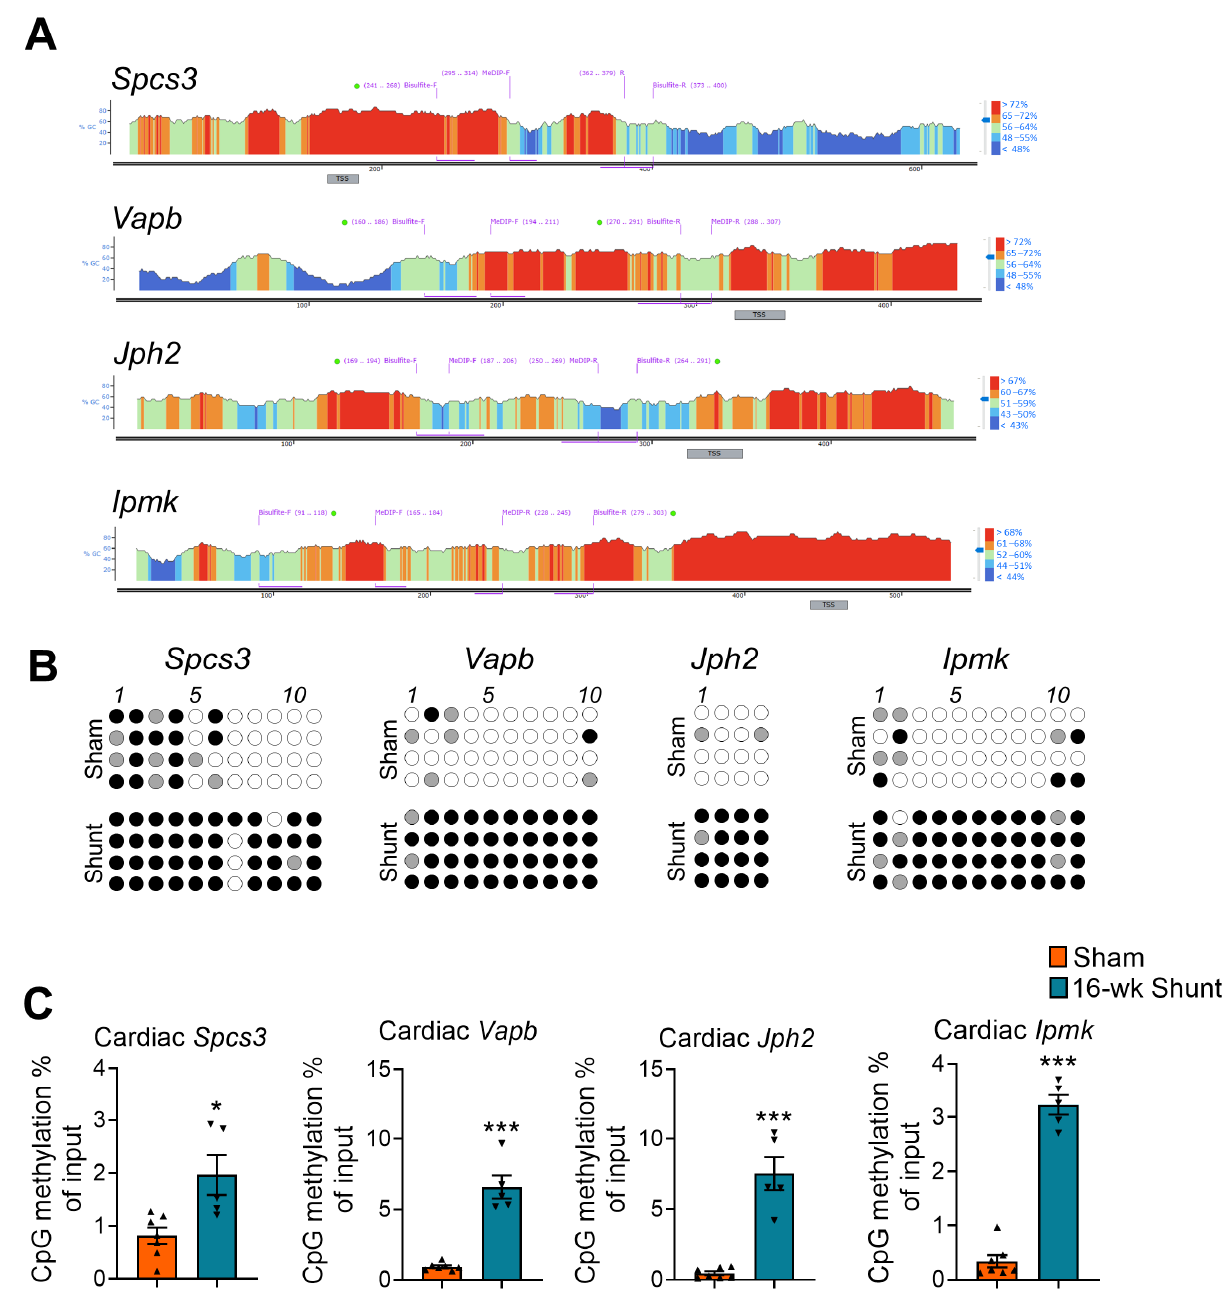
Figure 3. Gene-specific promoter DNA methylation assessment with bisulfite sequencing and MeDIP-qPCR. ( A ) Histogram showing the CpGs content at the gene promoter region. The locations for bisulfite sequencing and MeDIP-qPCR primers are indicated on top of the histogram. ( B ) Bisulfite sequencing analysis showing the methylation status of CpGs at the selected candidate genes. Every panel shows the sequencing results derived from four different animals. Closed circles indicate methylated, open circles indicate unmethylated, and gray circles indicate undetermined CpGs. ( C ) MeDIP-qPCR results showing the promoter methylation level for the four selected genes. Values are mean ± SEM, n = 4–7 hearts/group. * p < 0.05, *** p < 0.001 vs. sham, two-tailed unpaired Student’s t -test.